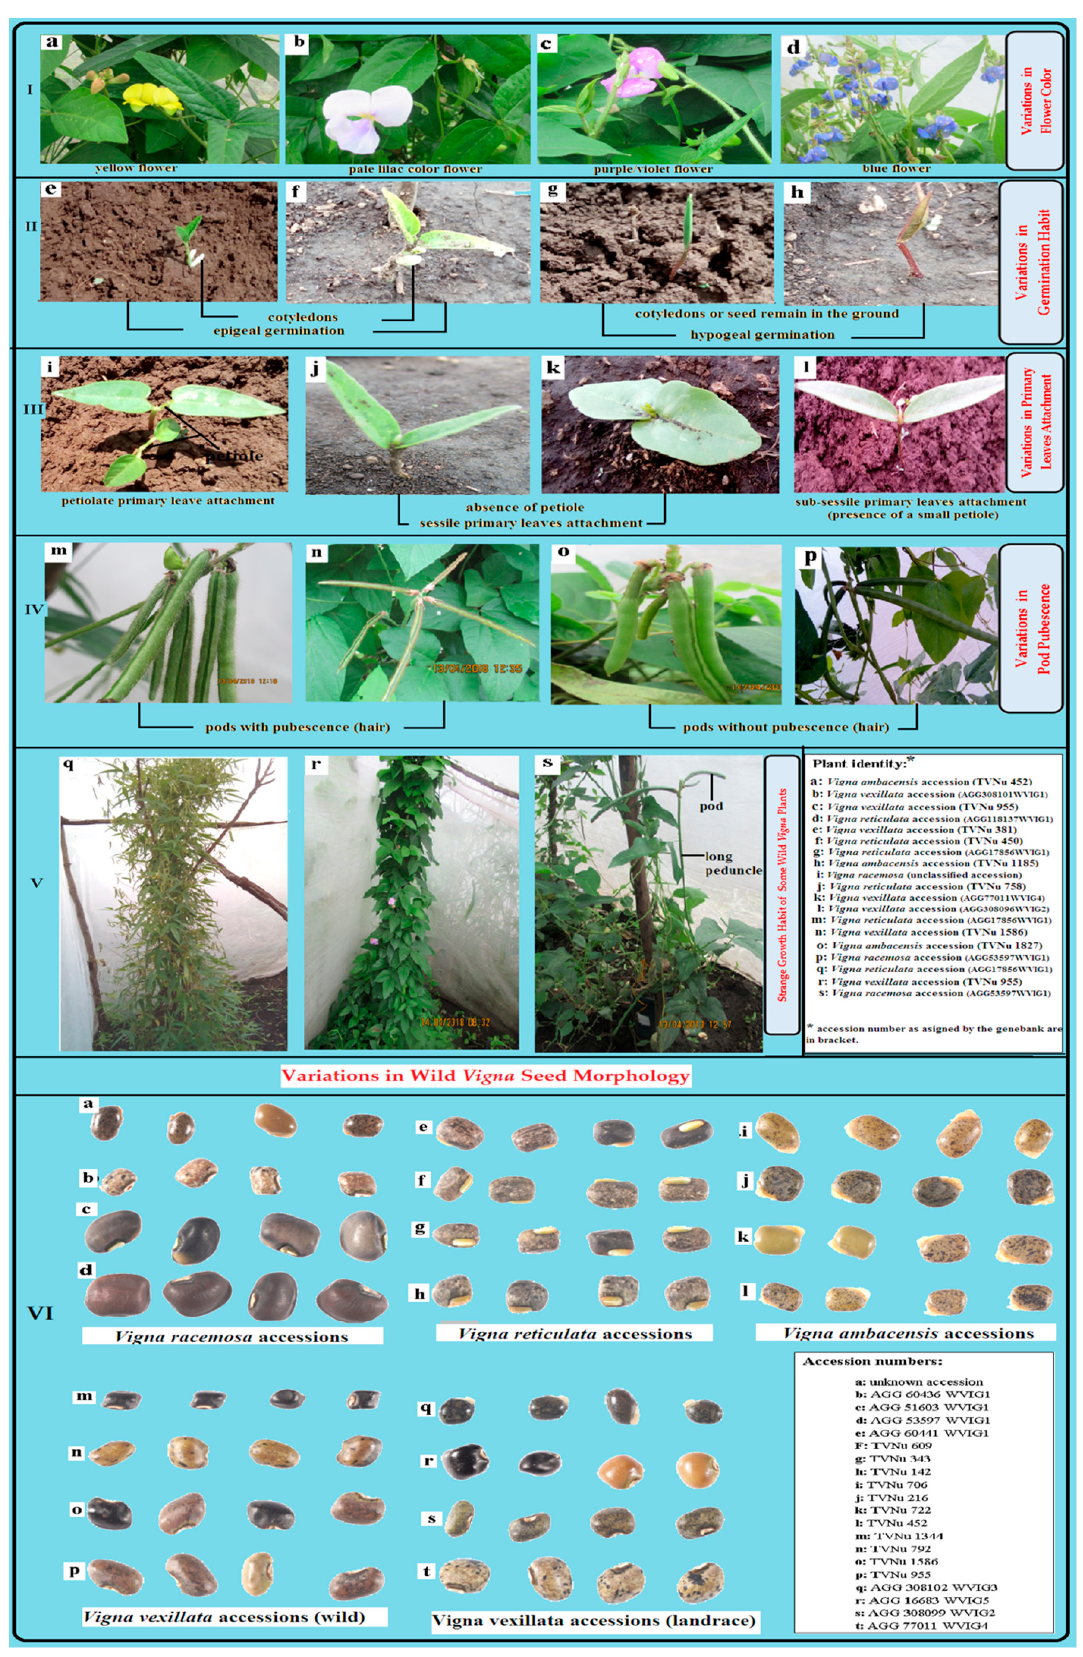
Figure 2. Some qualitative morphological characteristics of the studied wild Vigna.